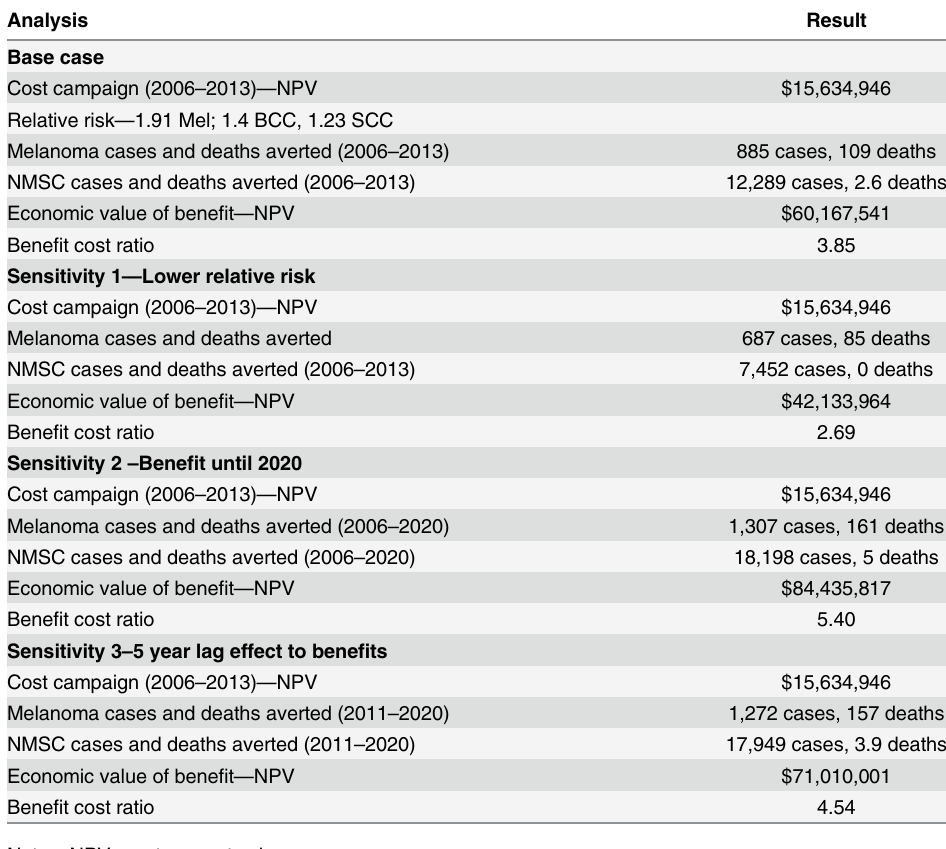
Table 5. Sensitivity